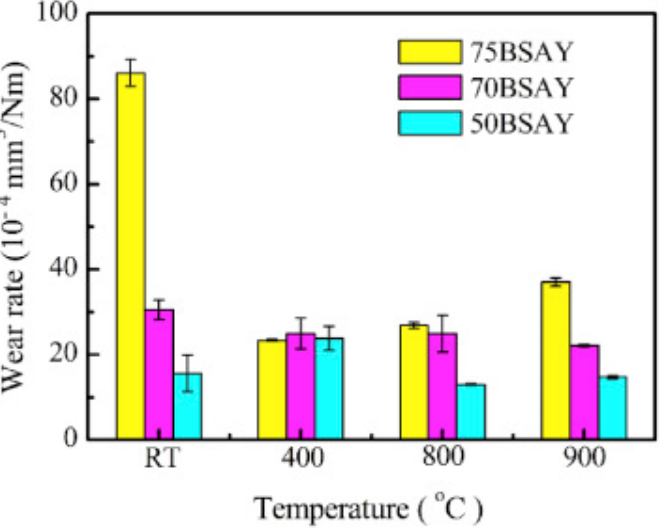
Figure 13. The variation in CoF for different test temperatures for the three composites. Reproduced with permission from [100]. Copyright Elsevier, 2020. with permission from [100]. Copyright Elsevier,